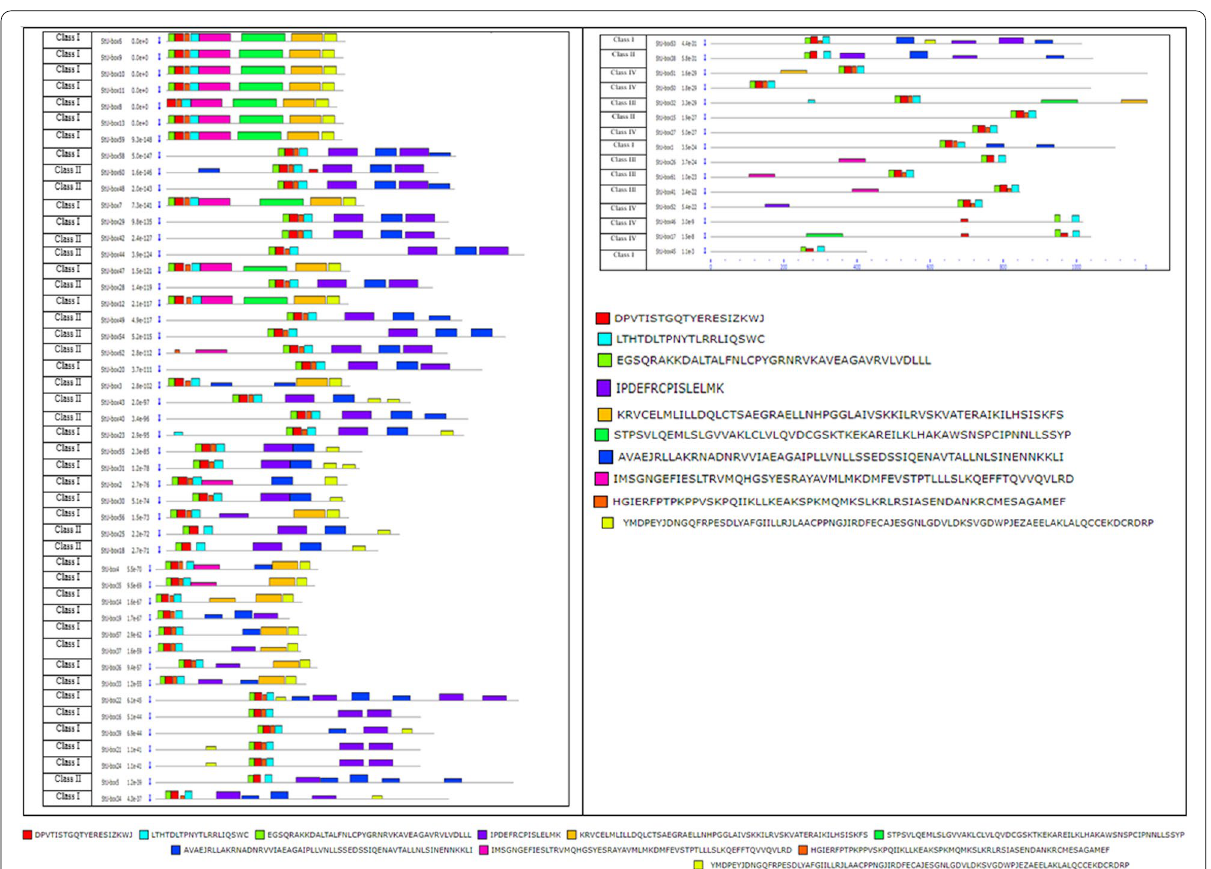
Fig. 2 Conserved motifs, displayed in different colored boxes, as detected by